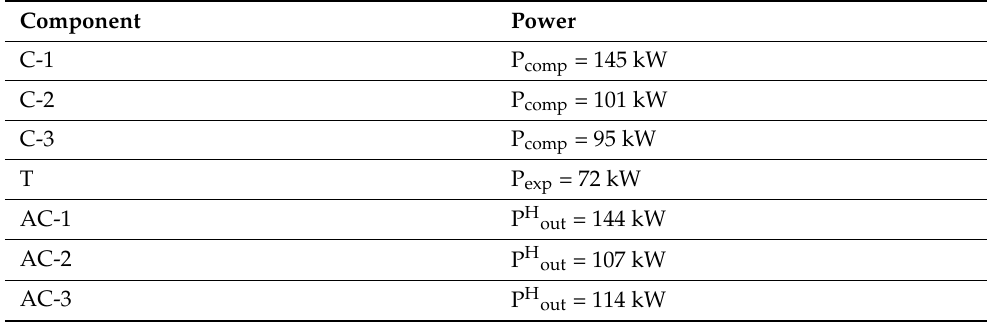
Table A6. This power data refer to operating unit in SV.